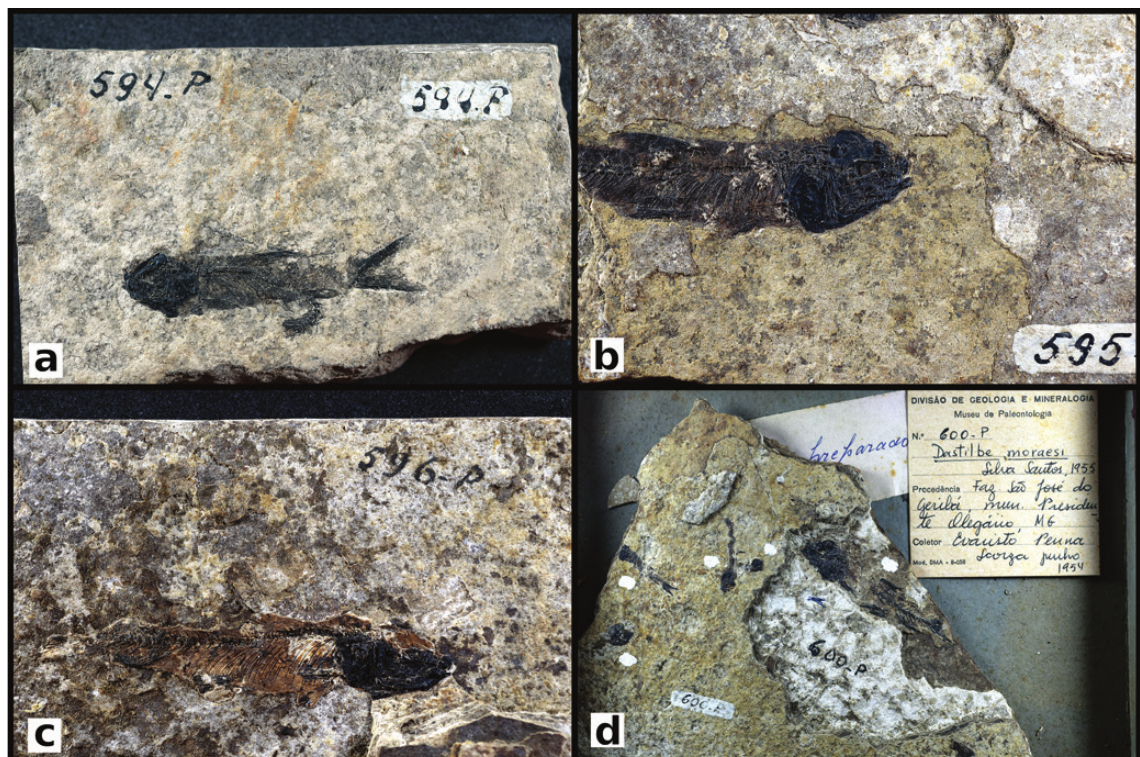
Fig. 1 . Paratypes of Dastilbe moraesi : a . DGM 594P, 33.7 mm SL, anterior to left; b . DGM 595P, 39.2 mm TFL, anterior to right; c . DGM 596P (larger specimen), 58.0 mm SL, anterior to rigth; and d . DGM 600P (larger specimen), 58 mm SL, anterior to